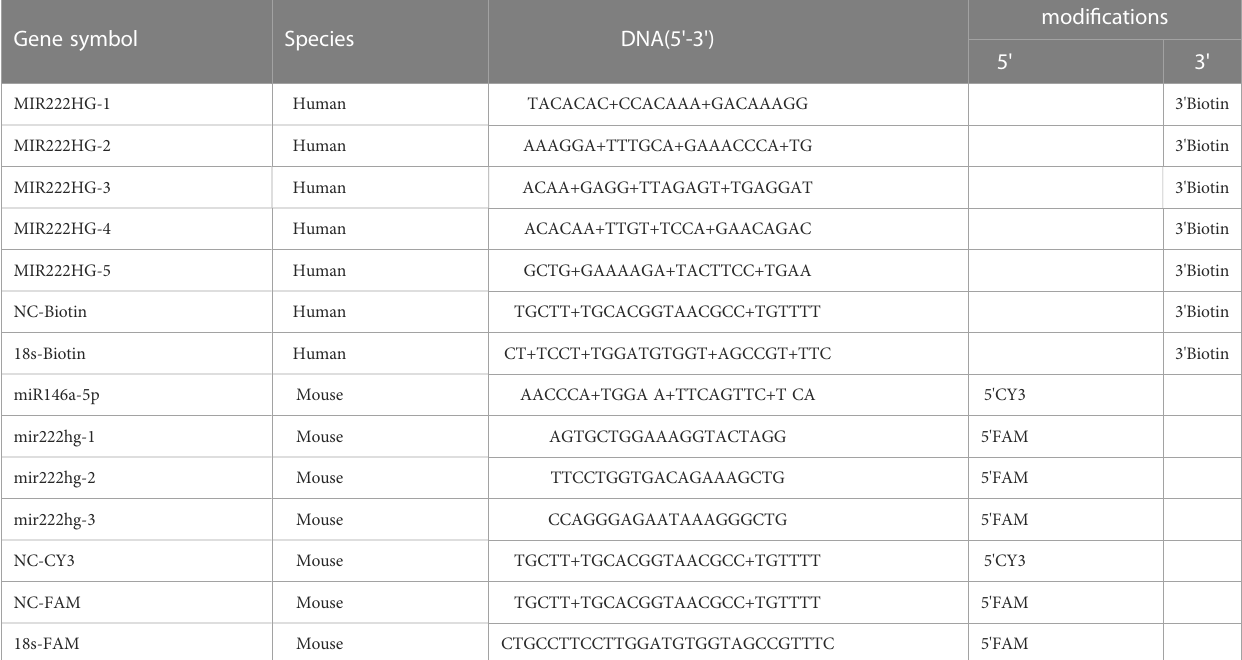
TABLE 4 List of probes used for